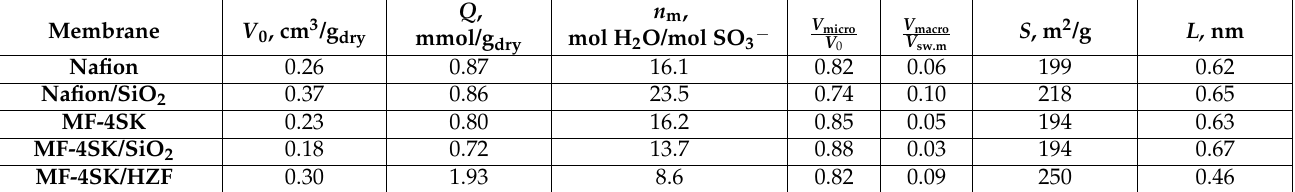
Table 1. Physicochemical characteristics of initial and modified perfluorinated membranes.